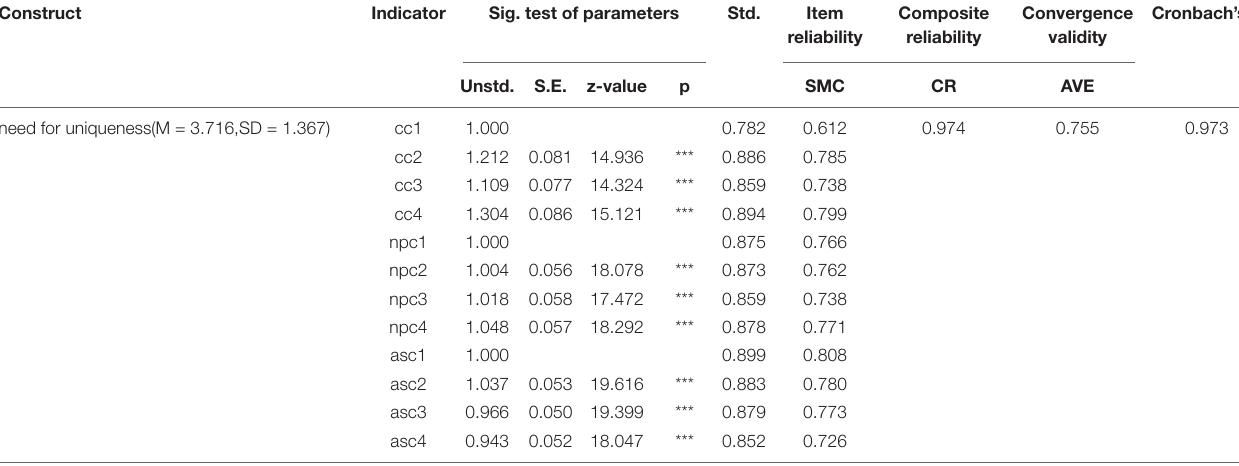
TABLE 1 | Reliability and convergent validity of need for uniqueness scale ( n = 210). Construct Indicator Sig. test of parameters Std.